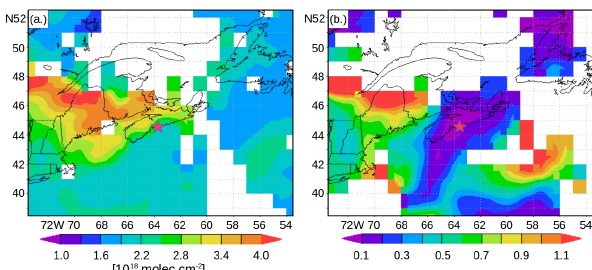
Figure 4. Satellite observations made during the 17:50UTC as- cending pass of Aqua over the DGS on 20 July 2011. (a) Total col- umn CO measured by the AIRS instrument (Level 3 daily standard physical retrieval V005) showing a large enhancement approach- ing the DGS (marked by star near centre of plot). (b) Simultane- ous 550nm aerosol optical depth as measured by the MODIS in- strument showing a region of low-aerosol loading above the DGS. White regions indicate interference from clouds.